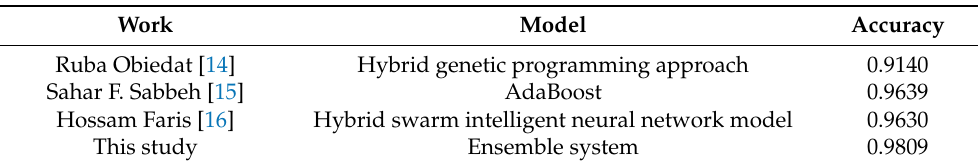
Table 8. Comparison with other